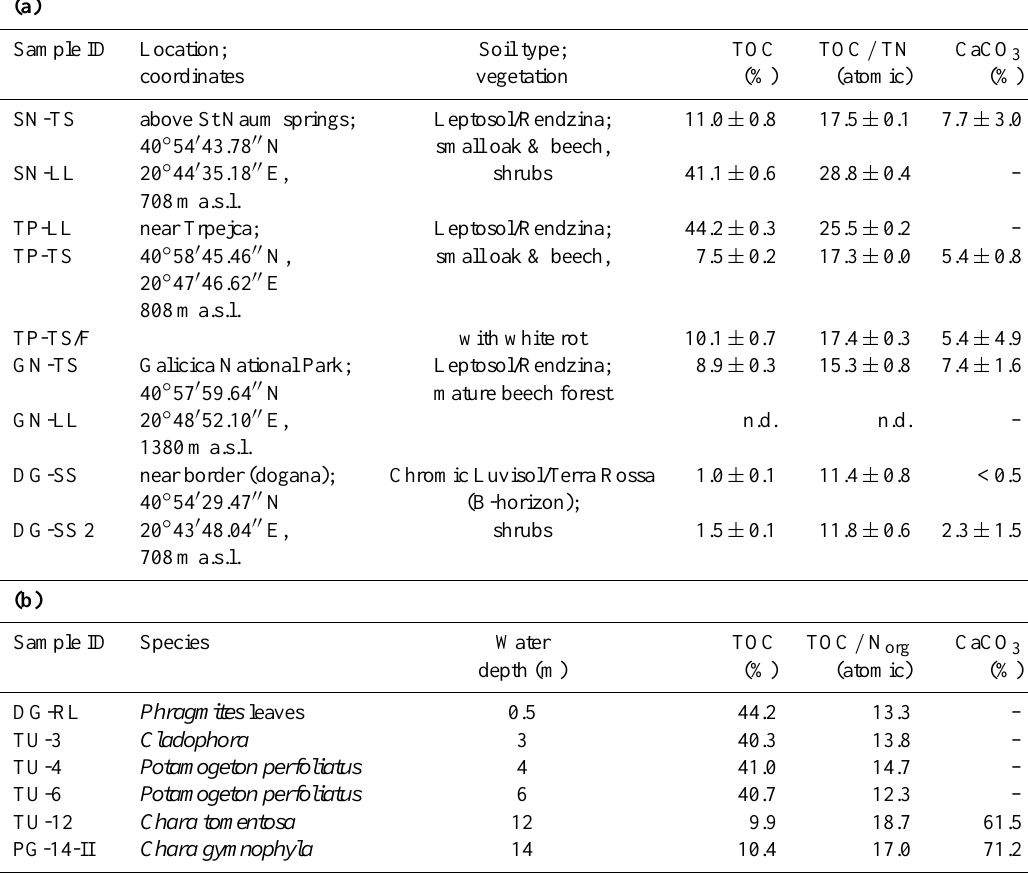
Table 1. (a) Total organic carbon contents (TOC), organic carbon to total nitrogen ratio (TOC / TN) and carbonate (CaCO 3 ) contents of soils and leaf litter in the southeastern Ohrid Basin (TS is topsoil, TS/F is topsoil with white rot, SS is subsoil, LL is leaf litter). For leaf litter, total nitrogen equals organic nitrogen. (b) Total organic carbon contents (TOC), organic carbon to organic nitrogen ratios (TOC / N org ) and carbonate contents (CaCO 3 ) of major Lake Ohrid macrophytes. Reed leaves (RL) were sampled near the Albanian–Macedonian border